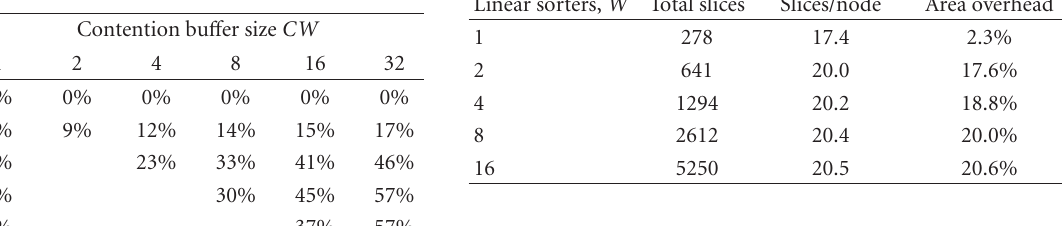
Table 3: Average latency speedup with contention bu ff ering for interleaved linear sorter of width W .